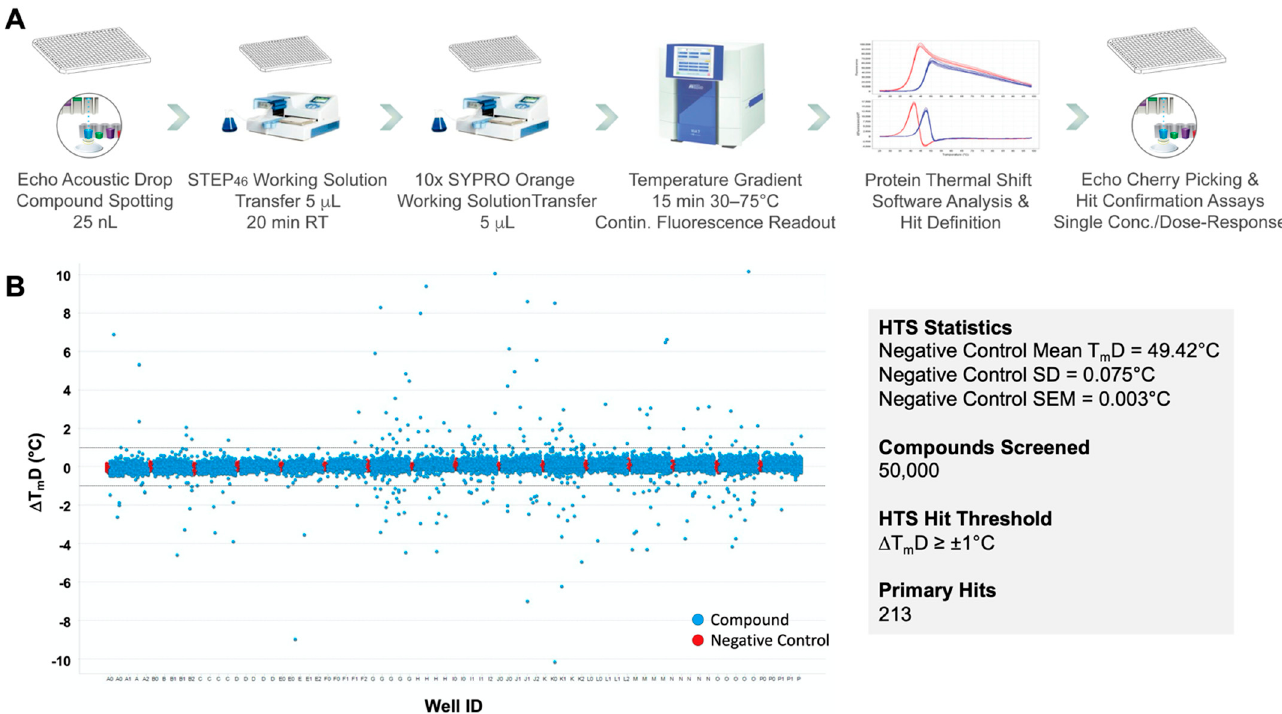
Figure 6. ( A ) Overall HTS workflow and instrumentation. Library compounds are spotted with an Echo 555 Acoustic Liquid Handler into 384-well PCR plates. STEP 46 and SYPRO Orange working solutions are added using a